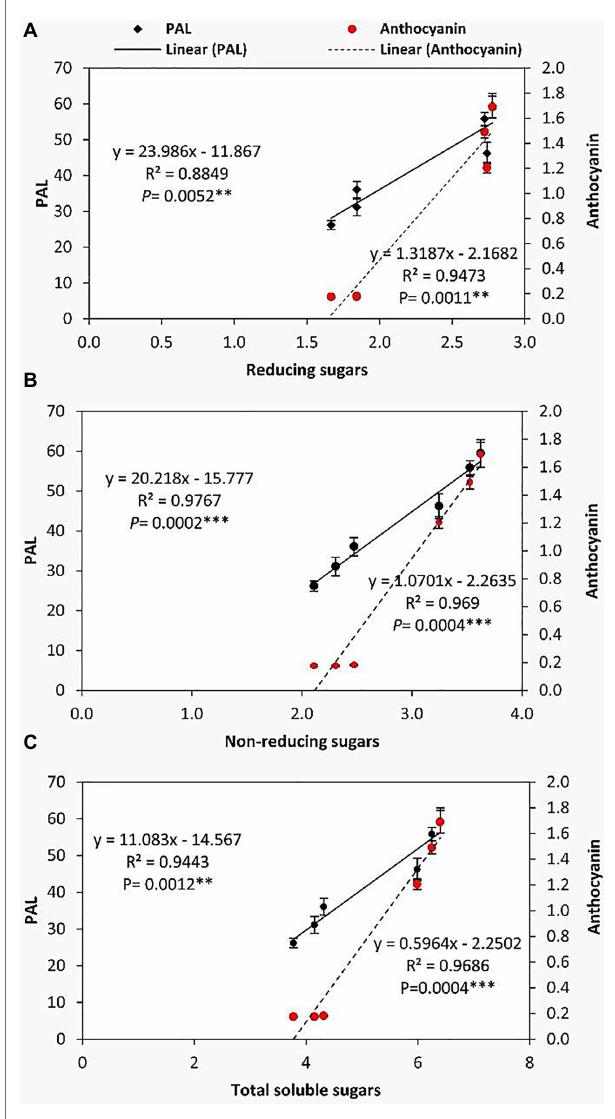
FIGURE 6 | Linear regression analysis elucidates the relationship between the soluble sugars, PAL enzyme activity, and anthocyanin contents in tomato plants cv “Super marmende” treated by γ -aminobutyric acid (GABA) as a foliar application at 1 and 2 mM and growing under normal (25°C/20°C day/ night) and chilling conditions (5 days/4ºC for 6 h/day) followed by 2 days recovery. ns. non-significant; * P ≤ 0.05; ** P ≤ 0.01; and *** P ≤